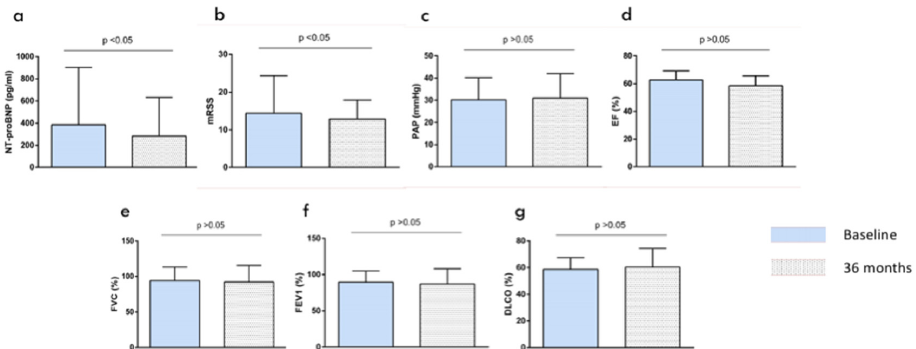
Figure 1. Patients characteristics at baseline and after 36 months of follow-up. Results are presented as mean ± standard error of the mean. ( a ) reduction in N-terminal-pro-brain natriuretic peptide (NT-proBNP) levels, ( b ) an improvement of the skin involvement as assessed by the Modified Rodnan Skin Score (mRSS) was documented, ( c ) no statistical significant changes in pulmonary artery pressure when comparing baseline and 36 month levels, ( d ) no patient showed any change in the ejection fraction, ( e ) forced vital capacity (FVC), ( f ) forced expiratory volume in one second (FEV1), ( g ) mean values of diffusing capacity for carbon monoxide